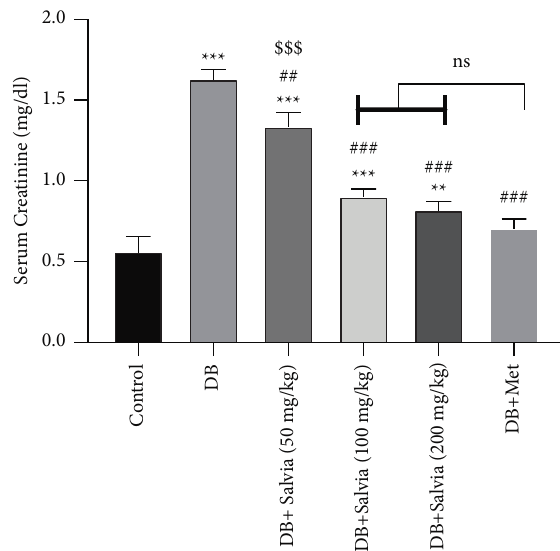
Figure 4: Effect of Salvia spinosa extracts on serum creatinine (sCr) concentrations in streptozotocin-induced diabetic mice. Control: normal mice, DB: diabetic mice, DB + Salvia: diabetic mice given the methanolic extract of Salvia spinosa , and DB + Met: diabetic mice given metformin (500 mg/kg). Values repre- sented as mean ± SD. ∗∗ P < 0 . 01 compared with control mice. ∗∗∗ P < 0 . 001 compared with control mice. ## P < 0 . 01 com- pared with diabetic mice. ### P < 0 . 001 compared with diabetic mice. $$$ P < 0 . 05 compared with metformin-treated diabetic mice. Ns: